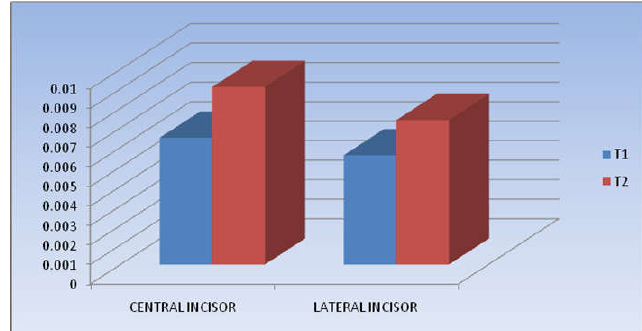
Graph 1. Comaparision of DSPP levels (ngL -1 ) between experimental groups before intrusion and 2 months of intrusion for central incisors (T1 C & T2 C ) & lateral incisors ( T1 L & T2 L )